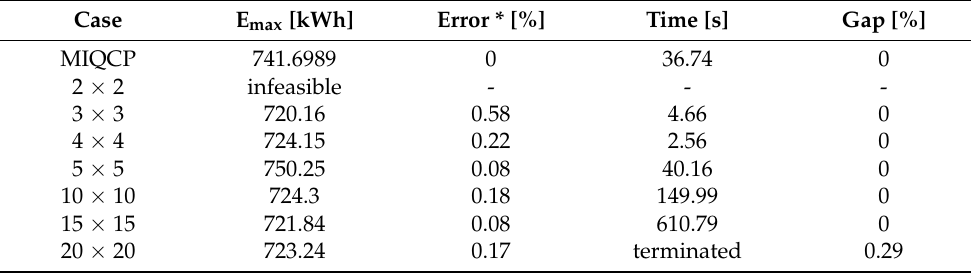
Table 2. Comparison of solving performance for Windows 10 × 64 with 8 GB RAM and Intel(R)